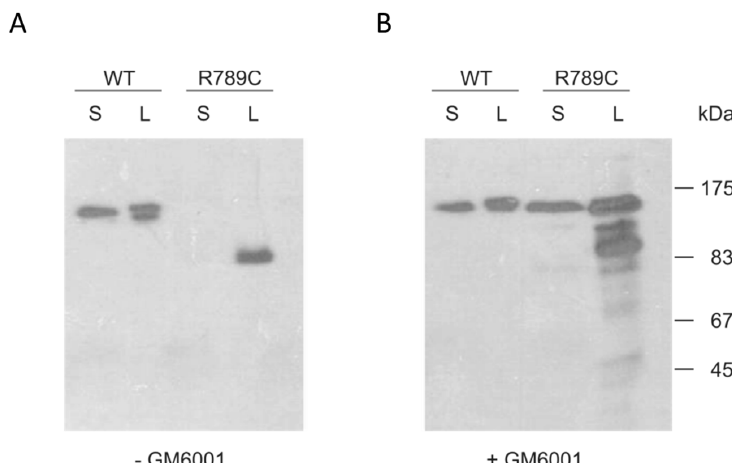
Figure 3. Analysis of proteolytic processing using the MMP inhibitor GM6001. Cells